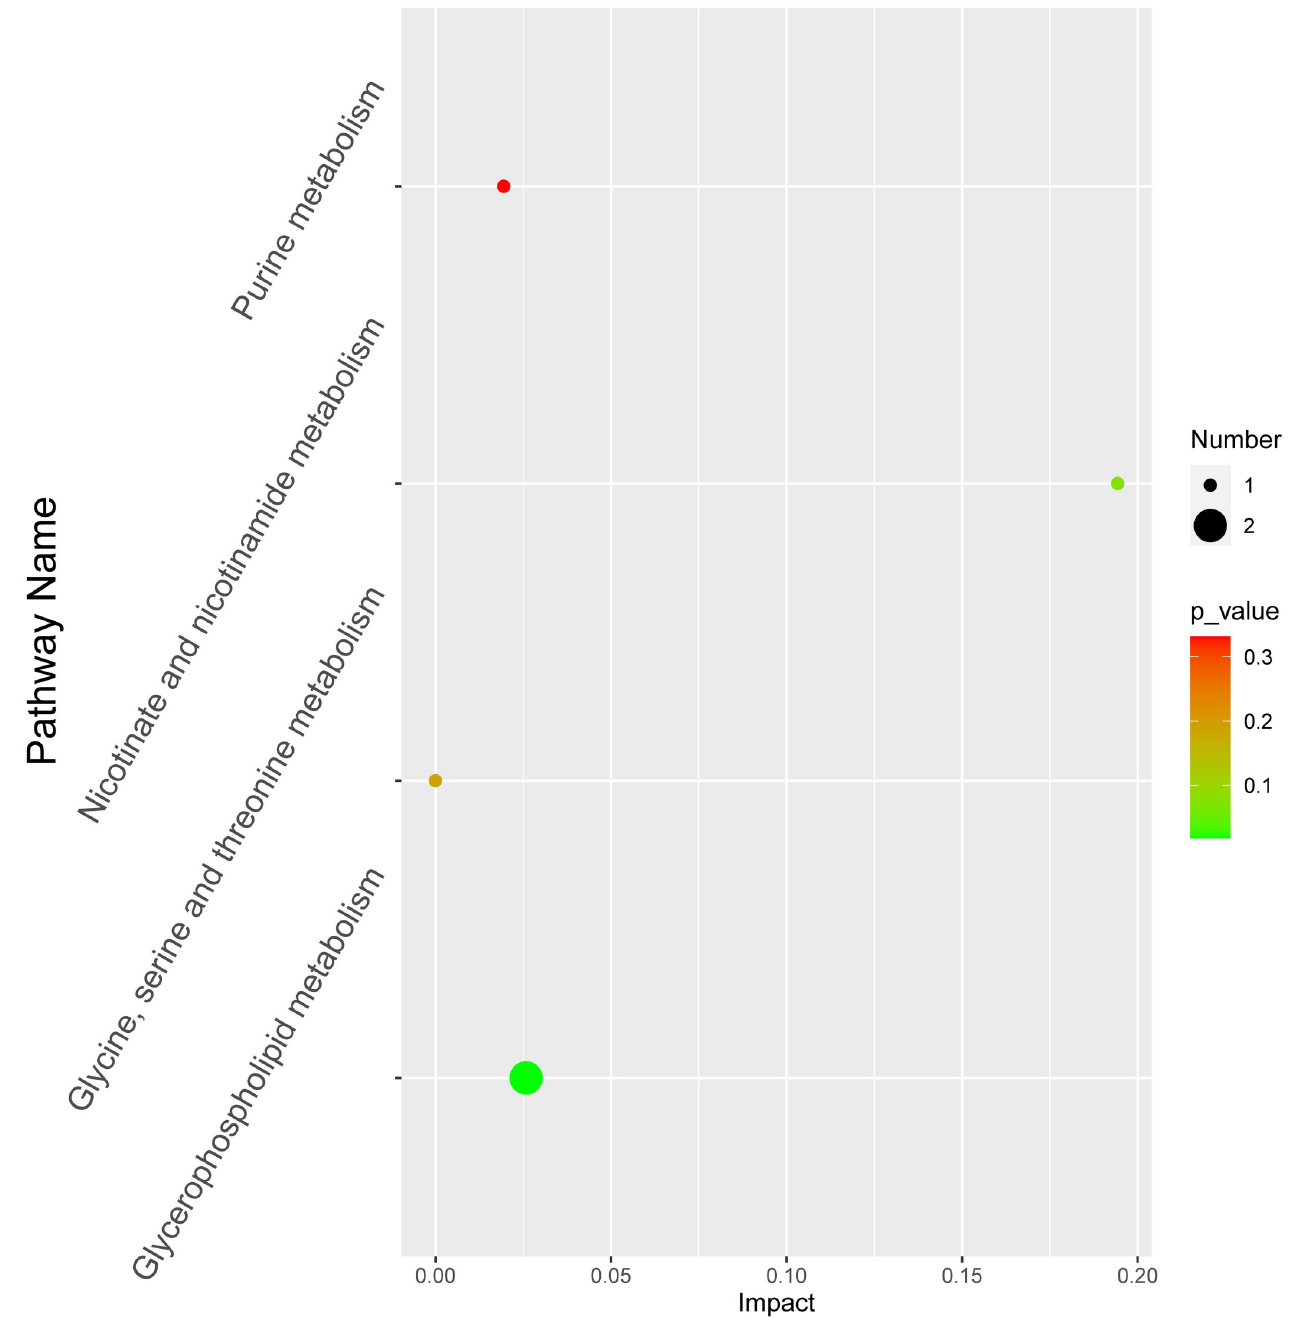
Fig 3. Metabolic pathways for 23 significantly differential regulated metabolites. The x-axis represents the pathway effect, and the y-axis represents the pathway name. Large sizes and dark colors represent the number of metabolites and p-value, respectively.